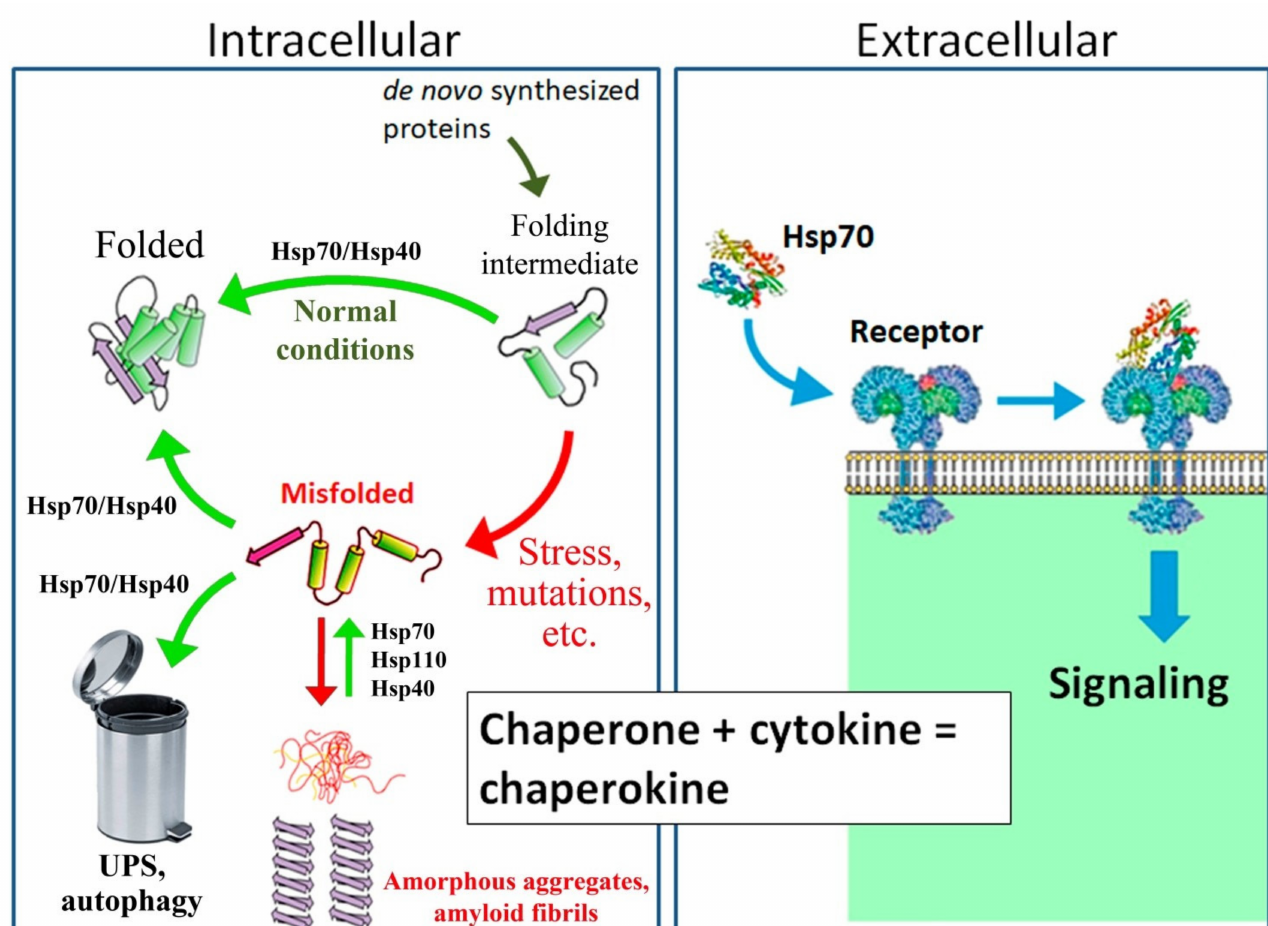
Figure 1. Mechanism of action of intracellular and secreted proteins of the Hsp70 family. As an intracellular housekeeping protein, Hsp70, in cooperation with Hsp40 and other co-chaperones, folds and sorts newly synthesized proteins in cells under normal conditions. Under proteotoxic stress and in the case of certain mutations, misfolded proteins accumulate in the cytosol. Hsp70, in cooperation with co-chaperone Hsp40, restores the native conformation of partially denatured proteins and directs irreversibly damaged proteins to the ubiquitin–proteasome system (UPS) or lysosomes by autophagy. In addition, Hsp70 in combination with Hsp110 and Hsp40 promotes the dissolution of protein aggregates, such as α - synuclein [12,17–20]. As a secreted protein, Hsp70 is recognized by TLR2/4 and CD91 receptors and participates in the regulation of innate immunity, similar to classical cytokines; hence, Hsp70 is often called a “chaperokin”